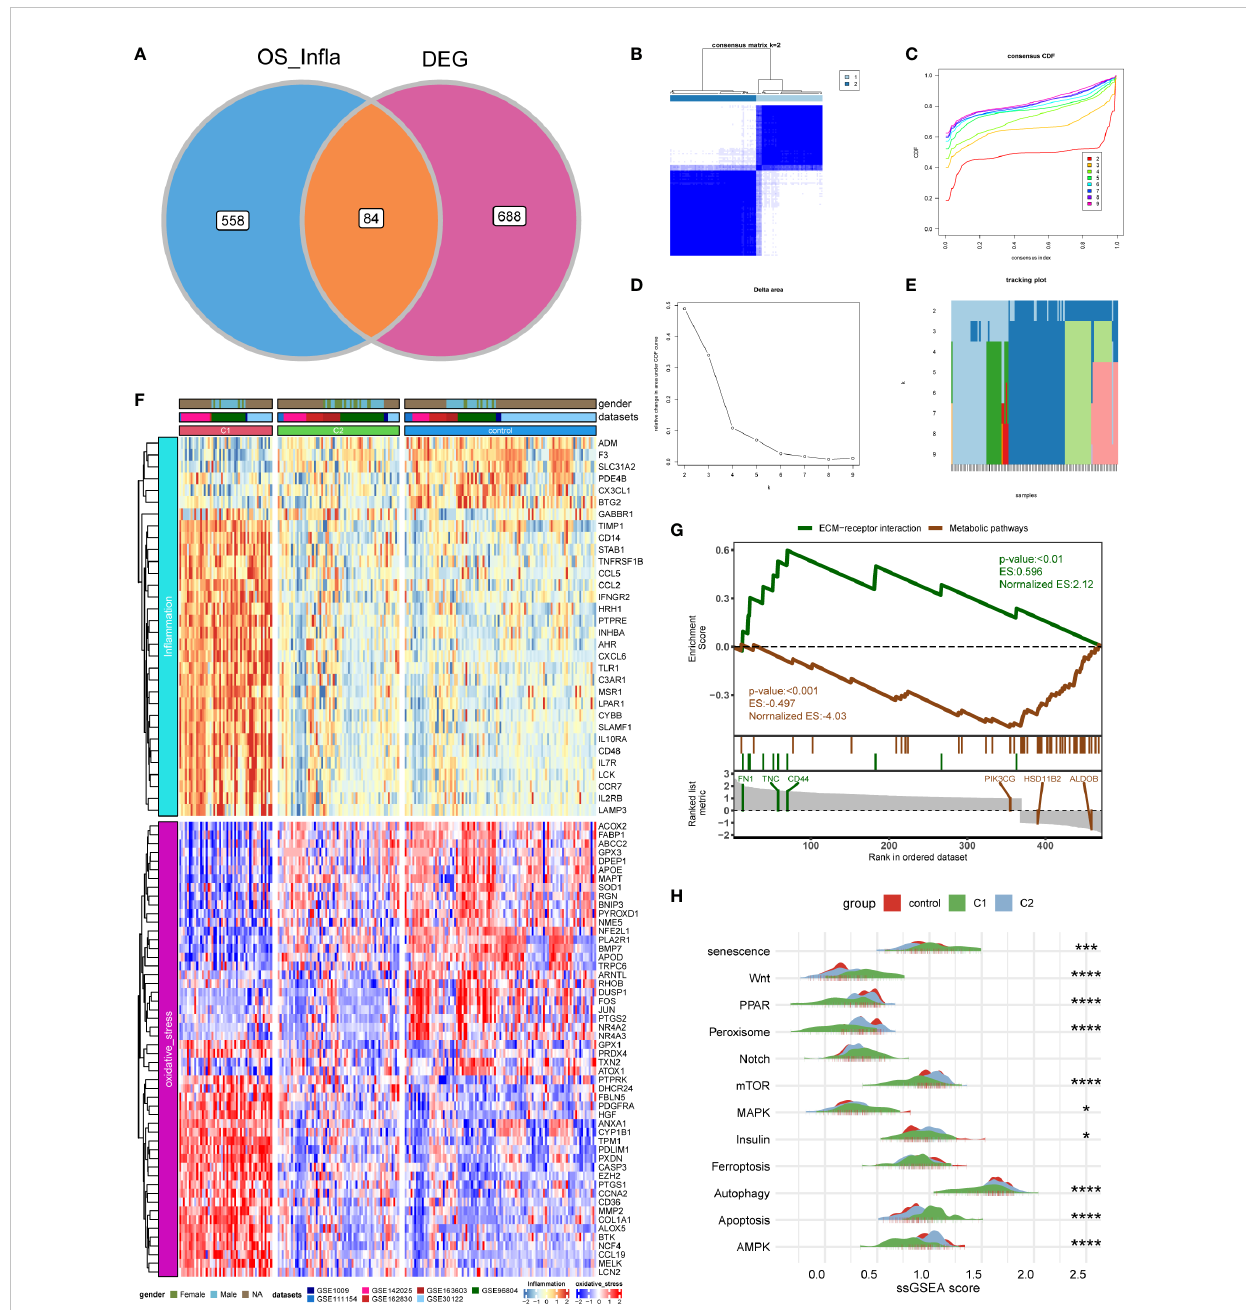
FIGURE 2 Identi fi cation of DKD subtypes. (A) Venn diagram showing the intersection of oxidative stress and in fl ammation-related genes (OS_In fl a) and DEGs. (B) Consensus matrix when k was 2. (C) Consensus distribution function (CDF) when K was between 2 and 9. (D, E) Relative changes in the area under the CDF curve for k = 2 to 9. (F) Expression heatmap of genes related to oxidative stress and in fl ammatory response among C1 and C2 subtypes and normal samples. (G) A gene set enrichment analysis (GSEA) of the status of biological pathways in two DKD subtypes. (H) The mountain graph showing the differences in DKD characteristic pathway scores among C1 subtype, C2 subtype, and normal samples. (Kruskal – Wallis test, ****P < 0.001, ***P < 0.005, *P <